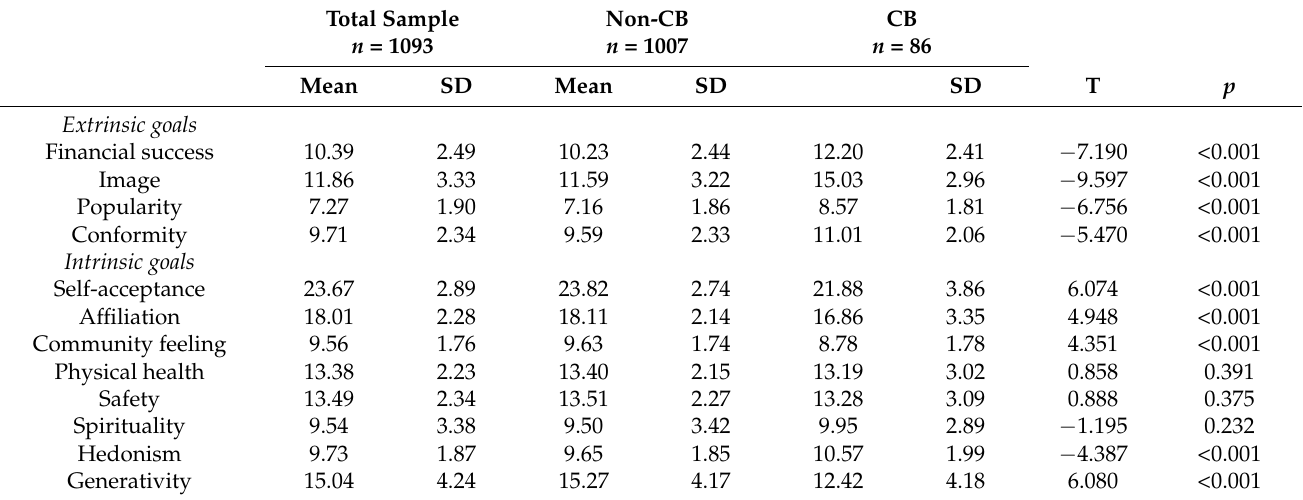
Table 1. Comparison between Non-CB and CB for goals.